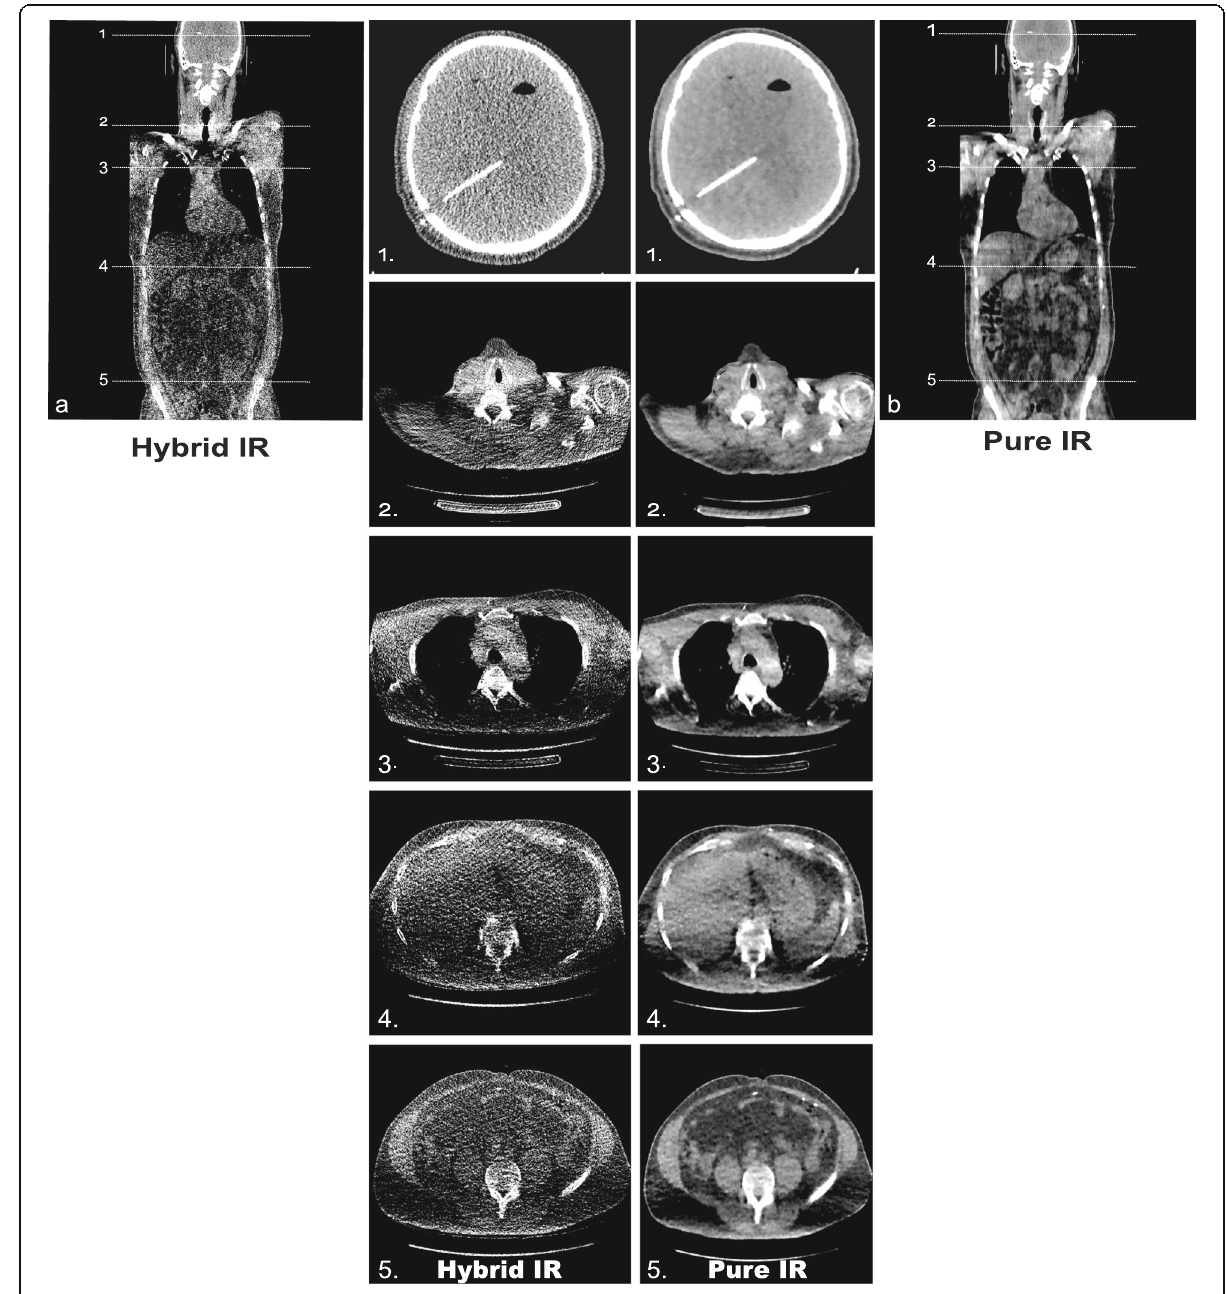
Fig. 4 Image quality comparison for ULD CT: hybrid versus pure IR. ULD CT coronal (3-mm thickness) images reconstructed with hybrid IR ( a ) and pure IR ( b ). Representative axial (3-mm thickness) images at five anatomical levels (1, head; 2, neck; 3, thorax; 4, abdomen; 5, pelvis) are shown for hybrid IR (left) and MBIR (right). Images were visualised using soft-tissue window settings (window width 400 HU; window level 40 HU). ASIR Adaptive statistical iterative reconstruction, CT Computed tomography, FBP Filtered back projection, IR Iterative reconstruction, MBIR Model-based iterative reconstruction, ULD Ultralow